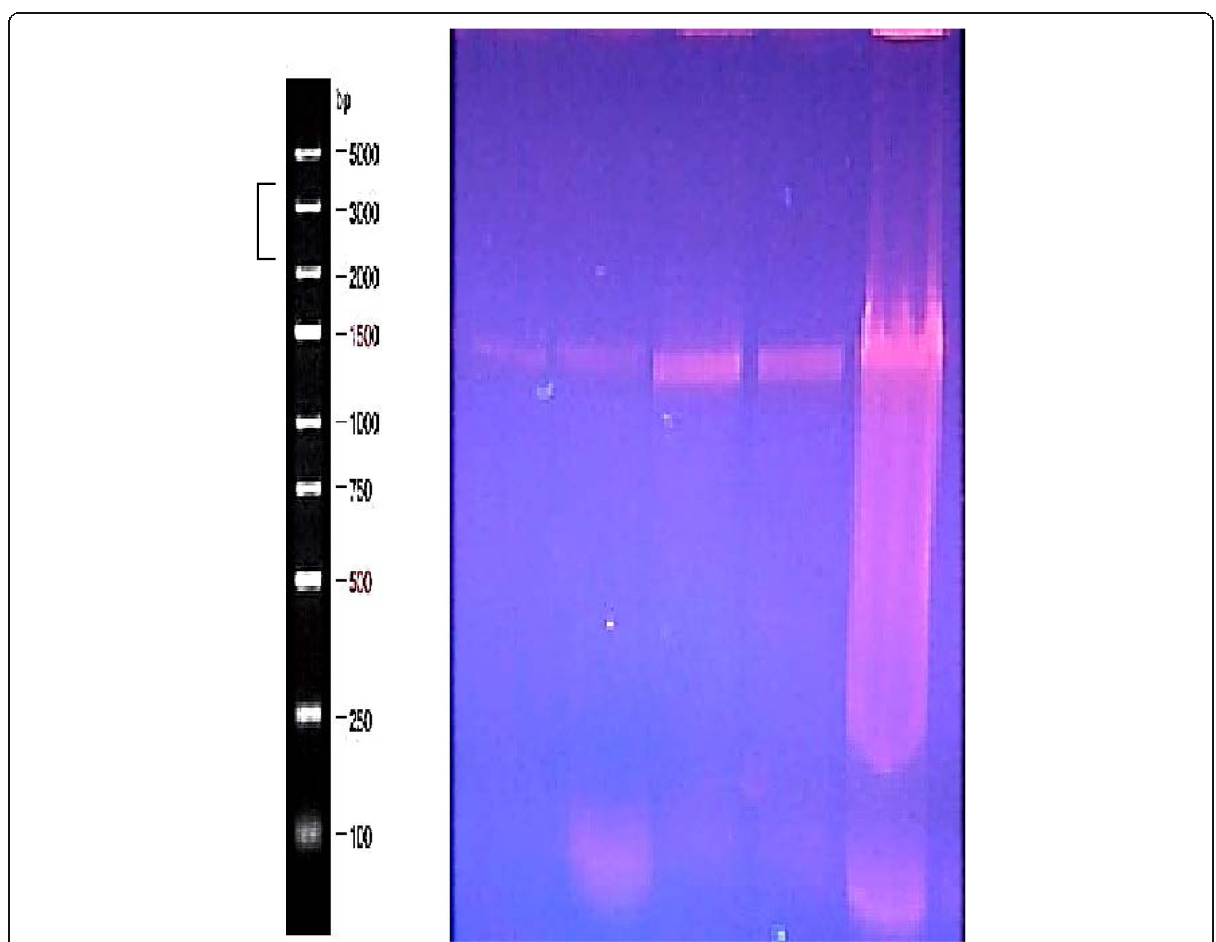
Fig. 1 Agarose gel electrophoresis for PCR amplicon from LacZ gene of the best six producers bacterial isolates: from left to right MKUV-Tra2, MKUV-Tra10, MKUV-Tra25, MKUV-Tra35, MKUV-Tra44, and MKUV-Tra52 and all against 250 bp GENESTA DNA Ladder